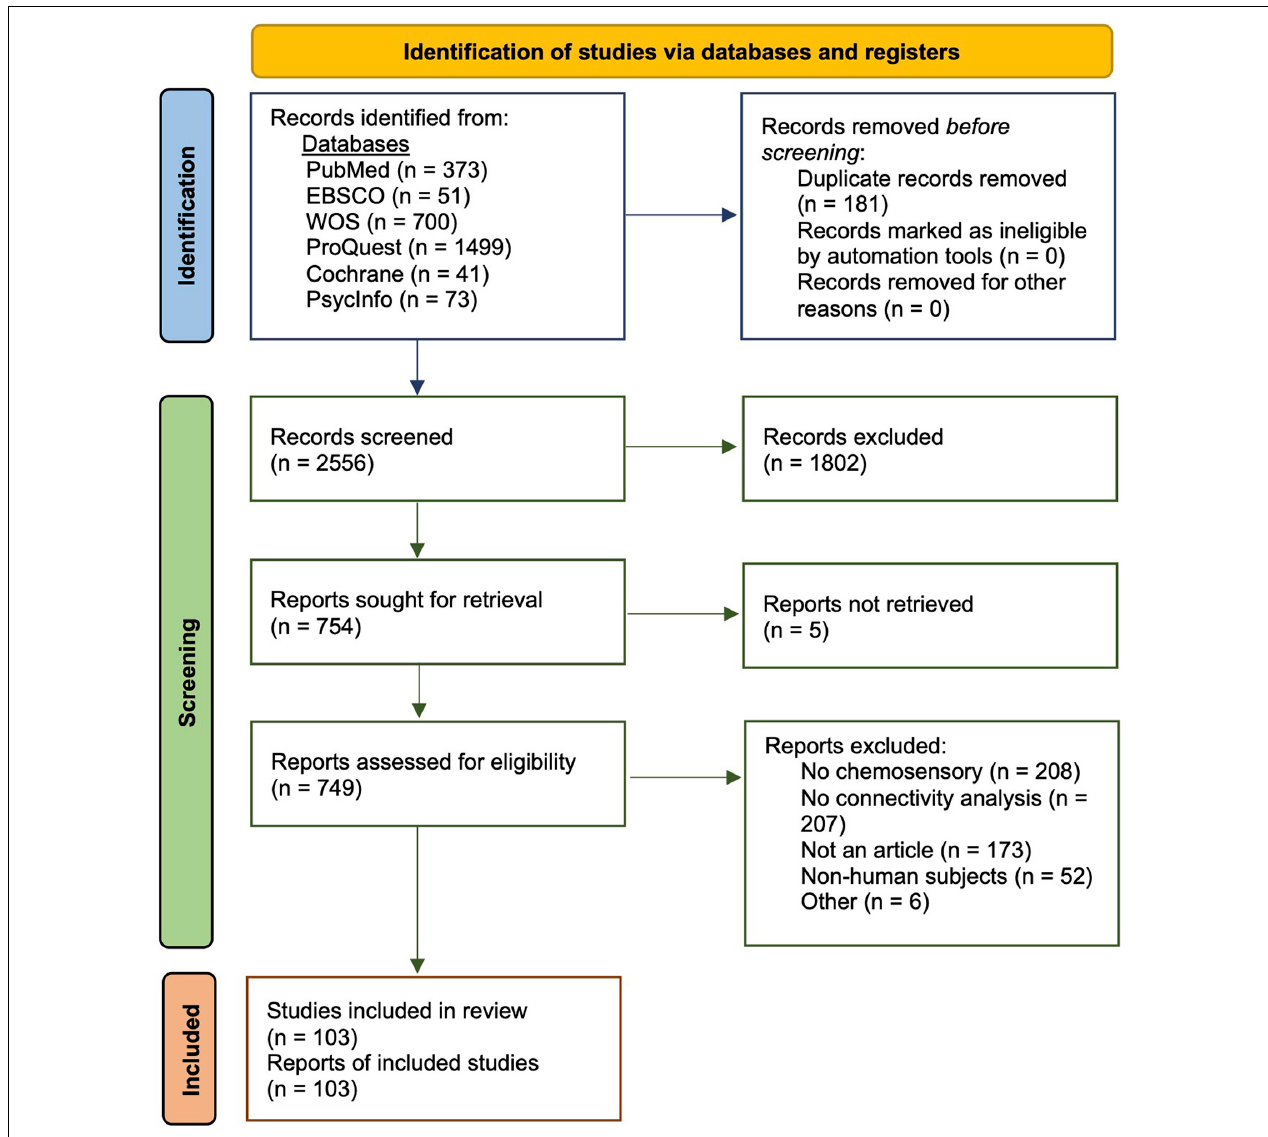
FIGURE 1 | PRISMA flow diagram and relevant search procedures used to obtain 103 chemosensory-related publications with functional connectivity analyses (Page et al.,